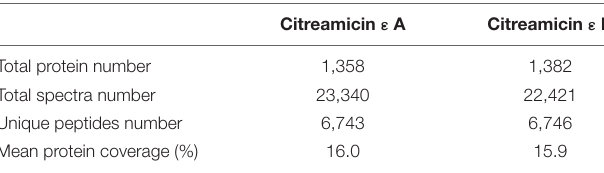
TABLE 1 | General protein and peptides